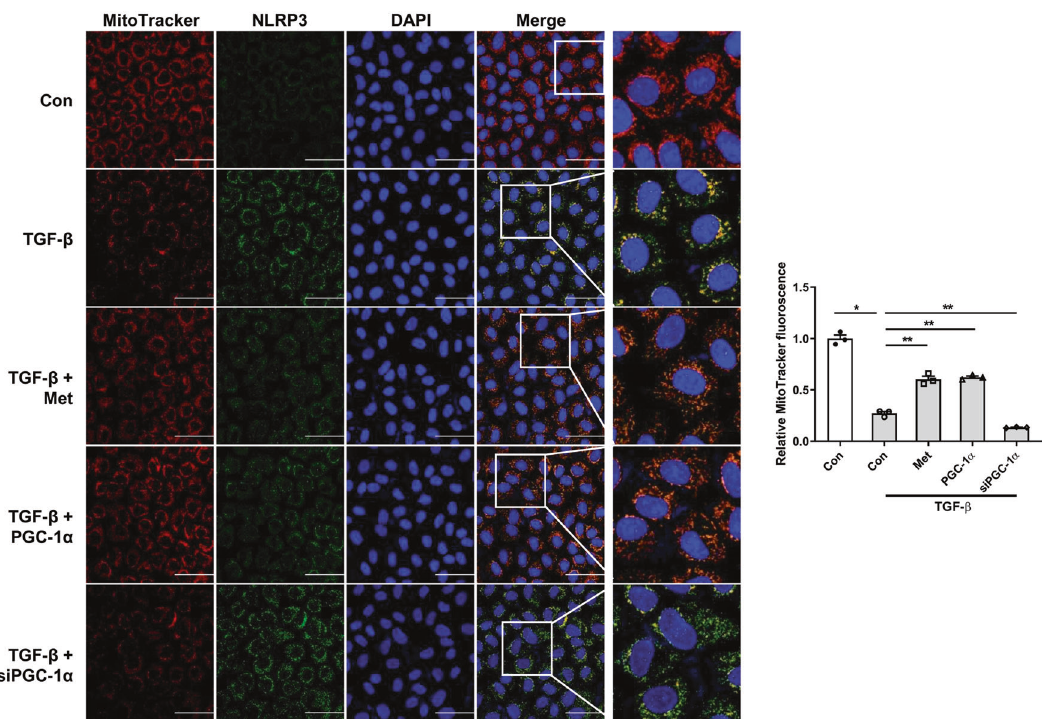
Fig. 7 Localization of NLRP3 with mitochondria with or without PGC-1 α . Confocal microscopy examination revealed that there was a reciprocal change in MitoTracker Red staining intensity (red) and NLRP3 expression (green) in RTECs with or without PGC-1 α However, these fi ndings were reversed by siPGC-1 α . The blue signal represents nuclear fl uorescence. Note: * P < 0.05 vs. control; ** P < 0.05 vs. TGF- β 1-treated RTECs. NLRP3 NOD-like receptor family, pyrin domain-containing 3; RTEC renal tubular epithelial cell; PGC-1 α peroxisomal proliferator- γ coactivator-1 α